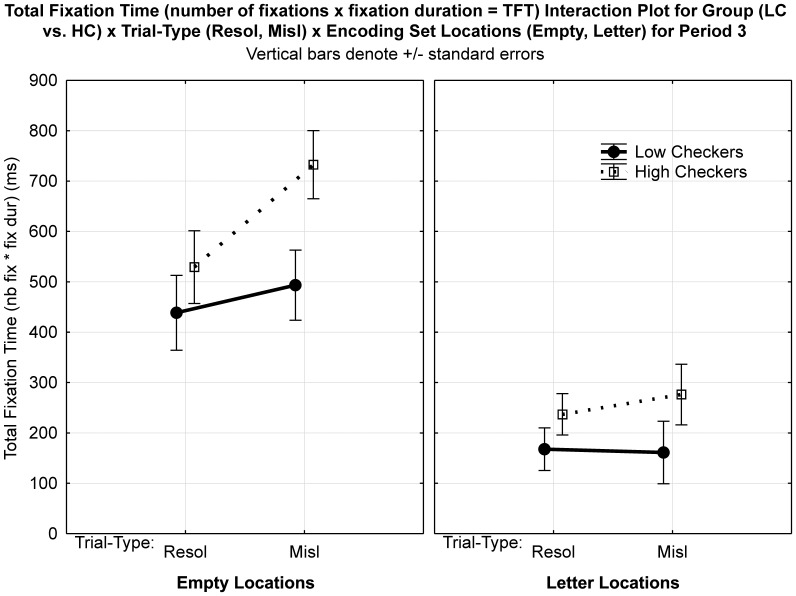
Total Fixation Time (TFT) interaction plot for Period 3.TFT was calculated as number of fixation multiplied by fixation duration. Group (Low Checker vs. High Checker) ×Trial-Type (Resolvable, Misleading) ×Encoding Set Content (Empty; left plot, Letter; right plot) Please note that ‘*’ denotes p<0.05 significance level and ‘**’ p<0.001.